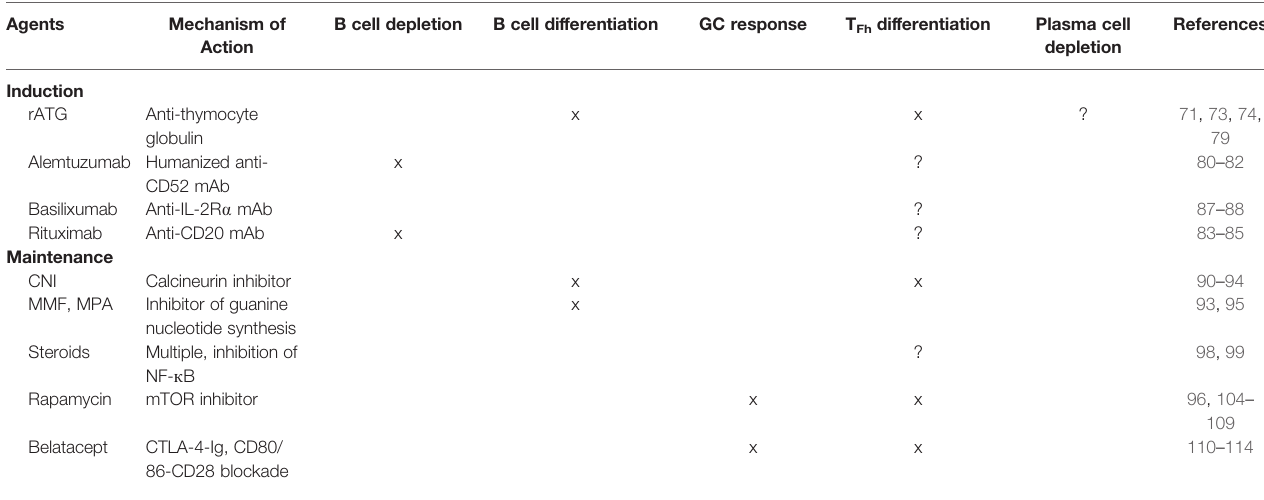
TABLE 1 | B cell response under current immunosuppressive